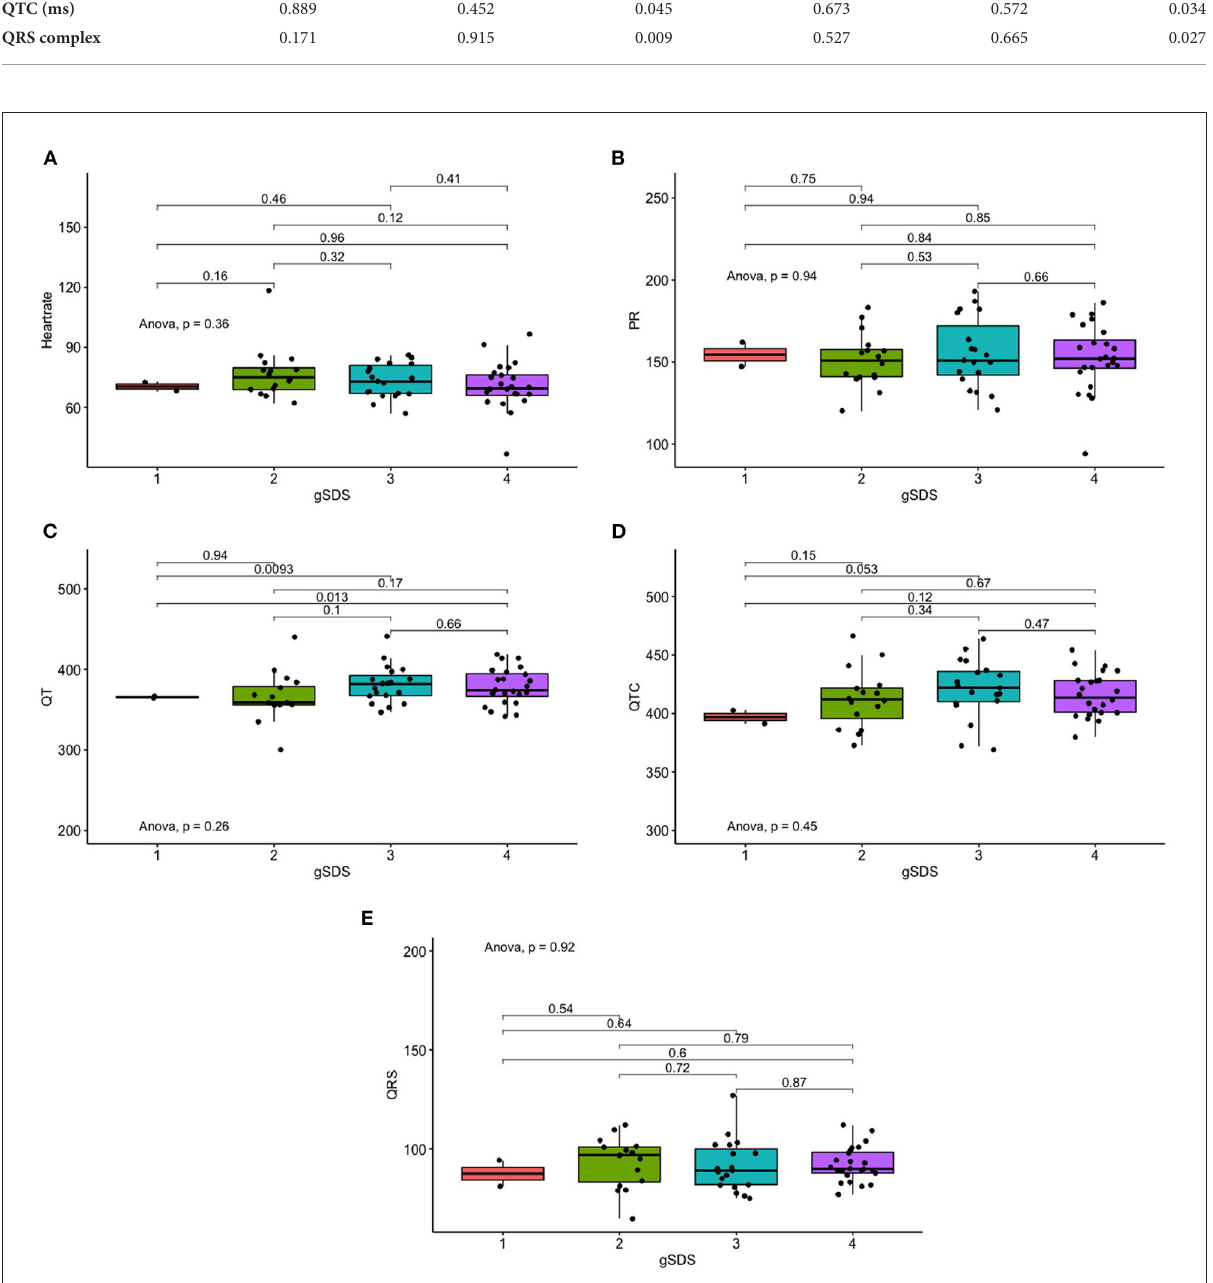
FIGURE1 Differences in ECG measures of depression severity. (A) Differences in Heart rate of depression severity. (B) Differences in PR of depression severity. (C) Differences in QT of depression severity. (D) Differences in QTC of depression severity. (E) Differences in QRS measures of depression